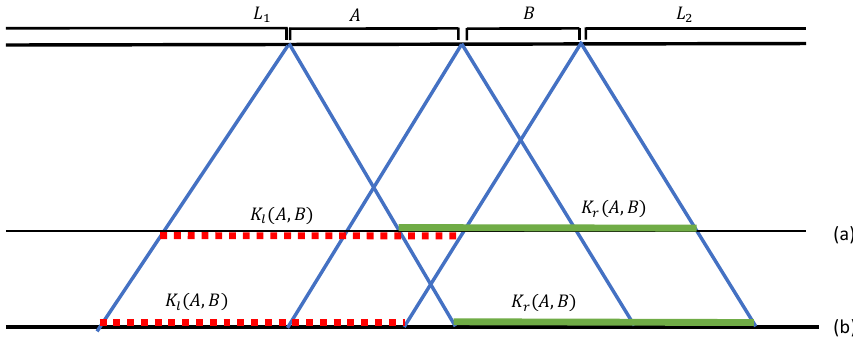
Figure 6 . Regions K l ( A, B ) and K r ( A, B ) of (2.32) at a time t < ( | A | + | B | ) / 2 in (a), and t > ( | A | + | B | ) / 2 in (b). The condition (2.32) holds at all times t > max ( | A | / 2 , | B | / 2) .